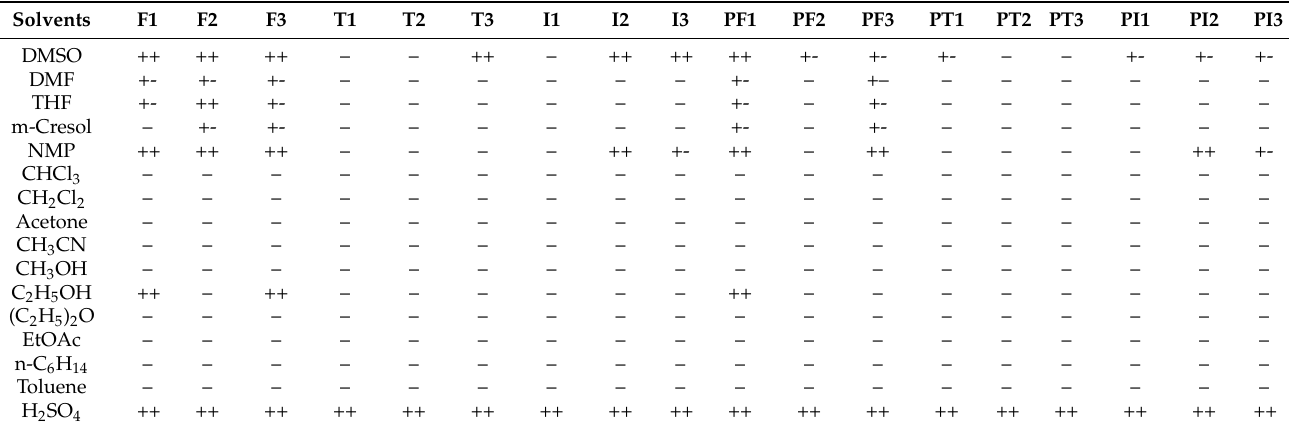
Table 1. Solubility data of the ferrocene-based terpolyamides, PDMS-containing block copolymers, and their organic